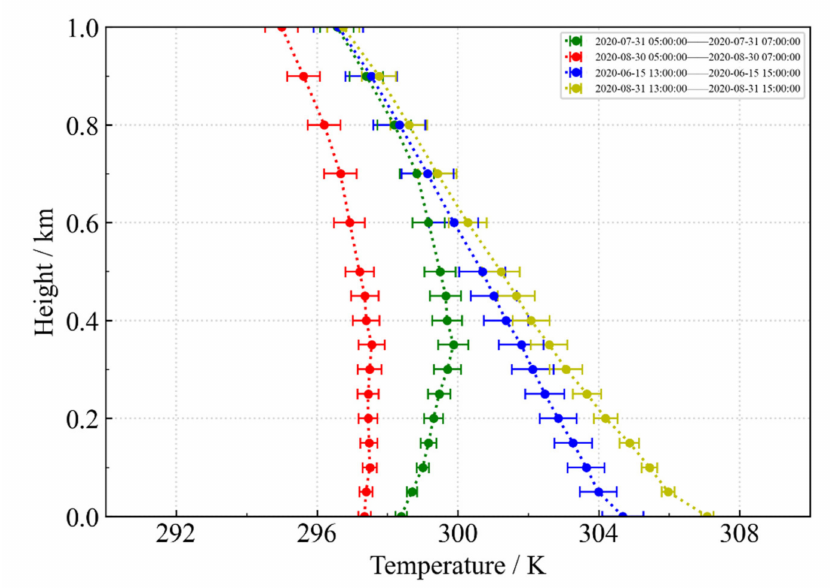
Figure 3. Temperature profile obtained at Lin’an Station on the day on which the extreme difference value was observed.